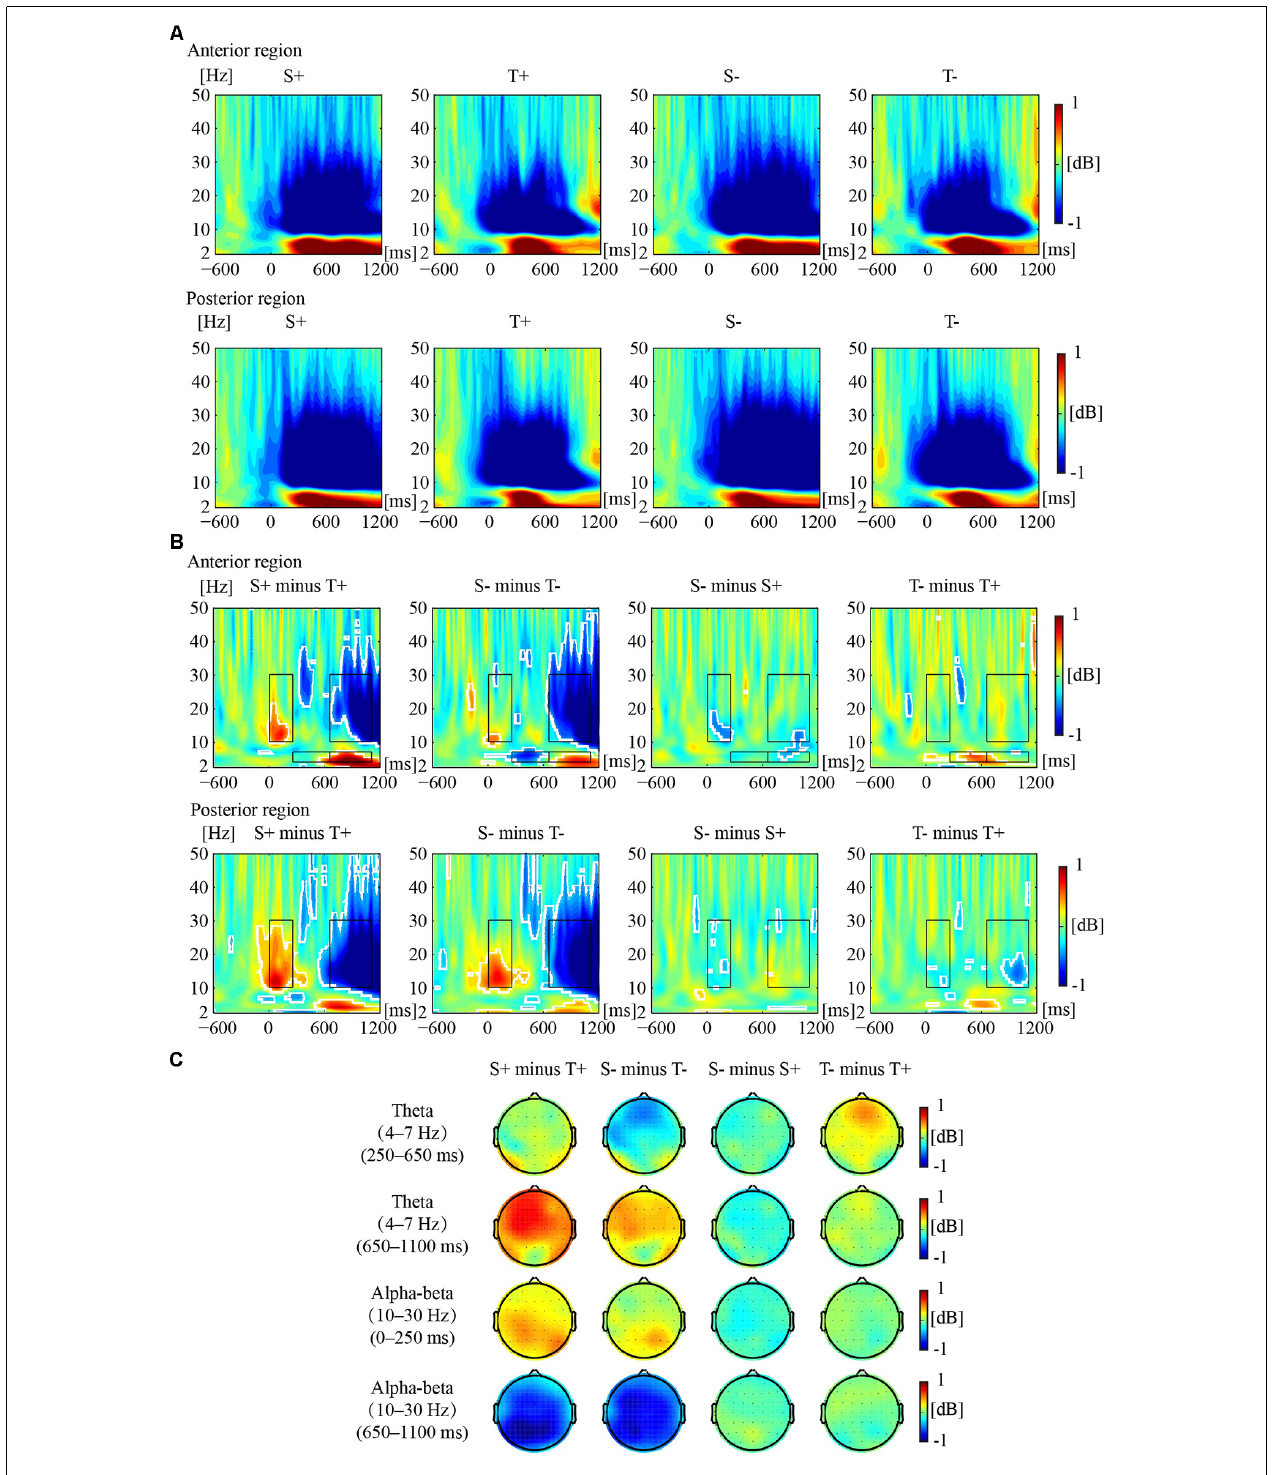
FIGURE 3 | Non-phased-locked EEG power responses to the premise monotonicity effect. (A) Grand-averaged power produced by S+, T+, S − , and T − arguments in the anterior and posterior regions. (B) The EEG power of “S+ minus T+”, “S − minus T − ”, “S − minus S+”, and “T − minus T+” is shown in the anterior and posterior regions. White outlines indicate the significant ( p < 0.01, FDR corrected) time–frequency pixels in the bootstrapping statistical analysis. Black outlines indicate TF-ROIs of the theta and the alpha-beta (10–30 Hz) bands. (C) Power difference topographies of the theta (250–650 ms and 650–1,100 ms) and alpha-beta (0–250 ms and 650–1,100 ms)